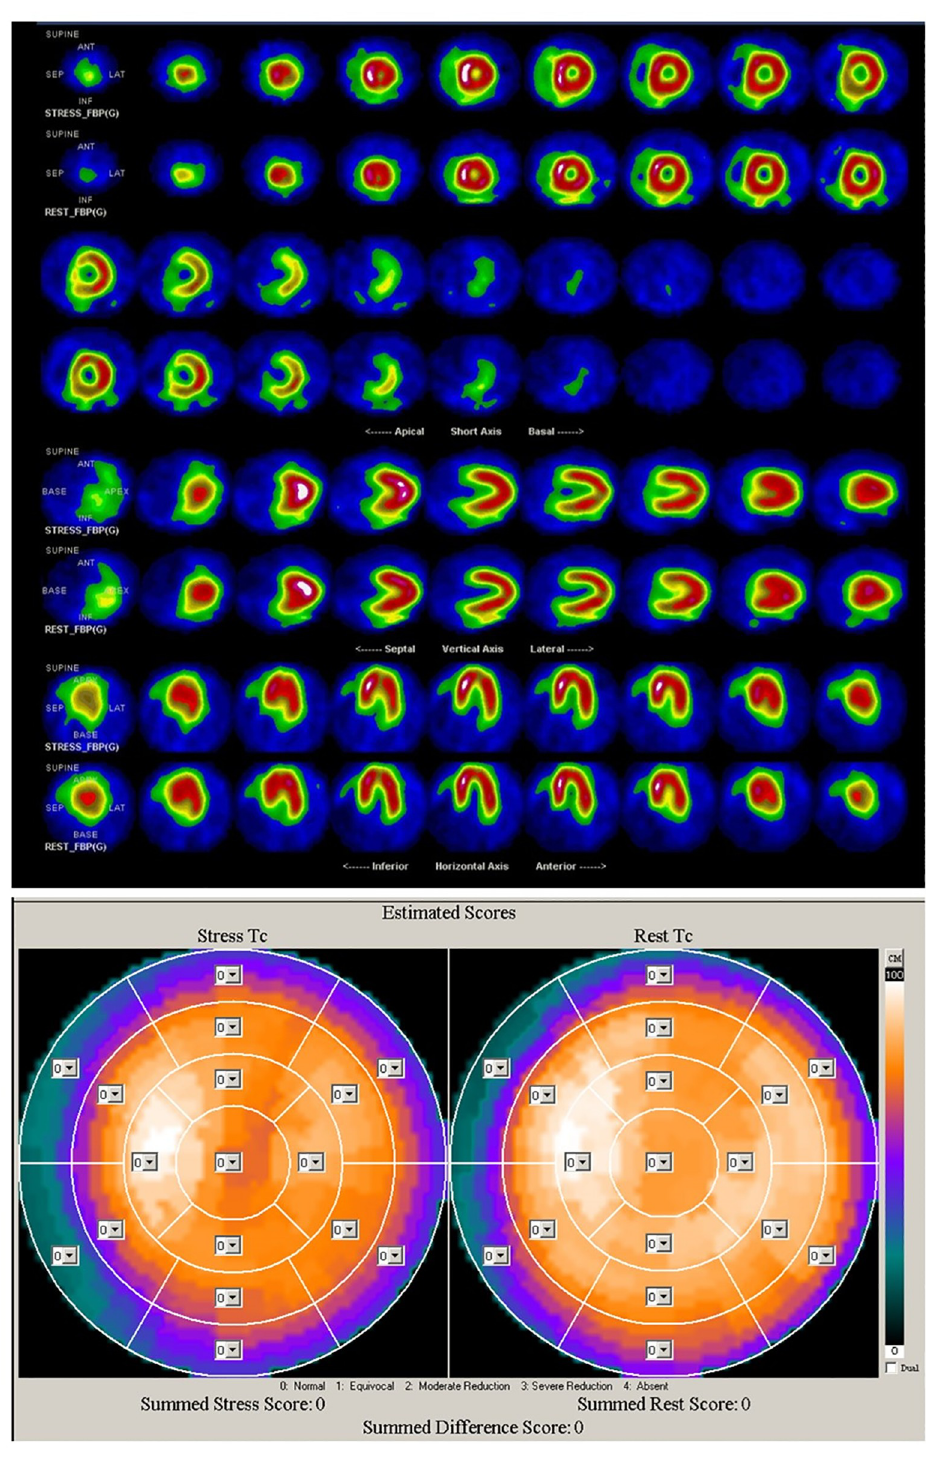
Fig 8. SPECT MPI results of GB0515. Both rest and stress SPECT ischemia score of GB0527 are 0.